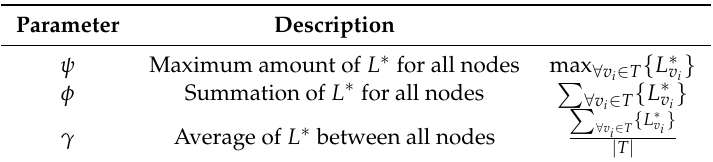
Table 3. Evaluation parameters.